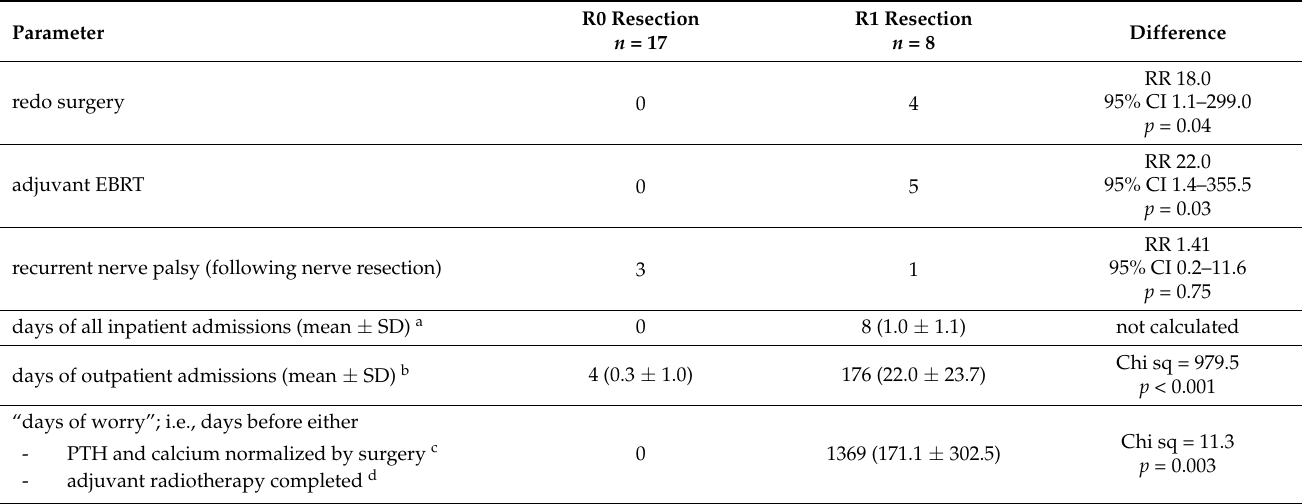
Table 6. Survivorship: therapy burden beyond the initial surgery depends on margin status after initial surgery.